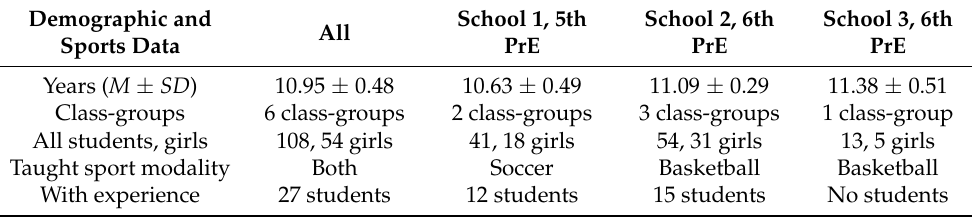
Table 1. Characteristics of the primary education students participating. Demographic